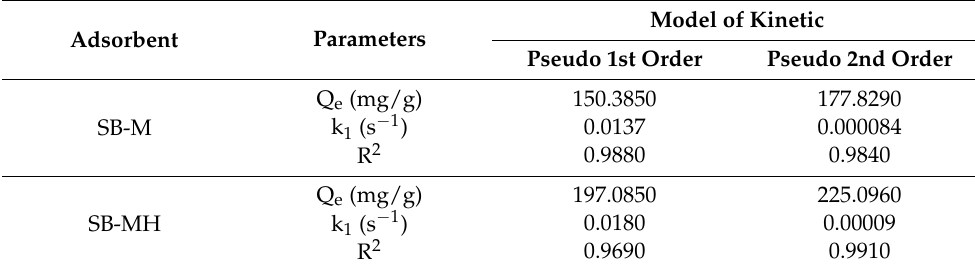
Table 1. Pb(II) Ion Adsorption Kinetics Parameters using SB-M and